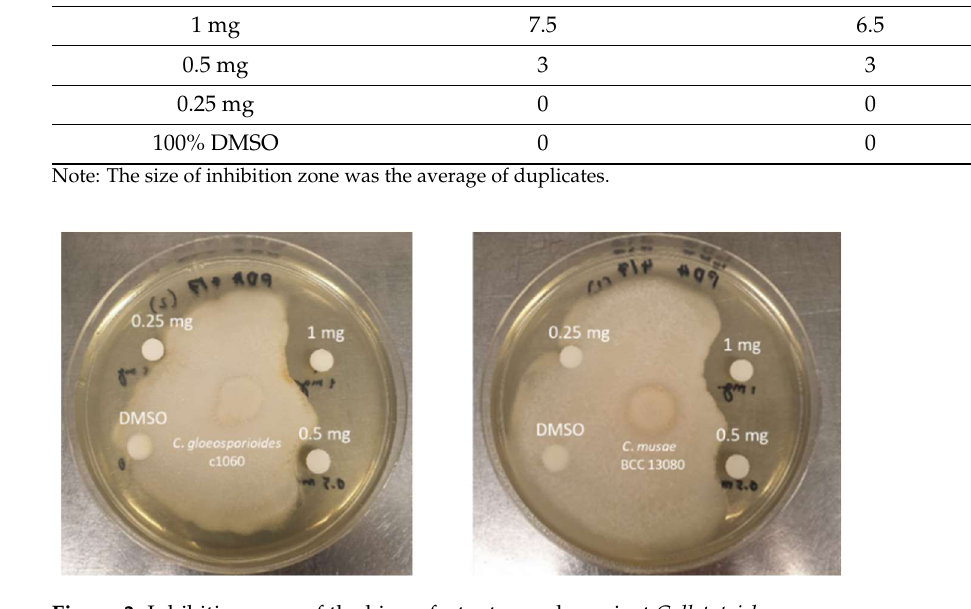
Figure 3. Inhibition zone of the biosurfactant sample against Colletotrichum sp.